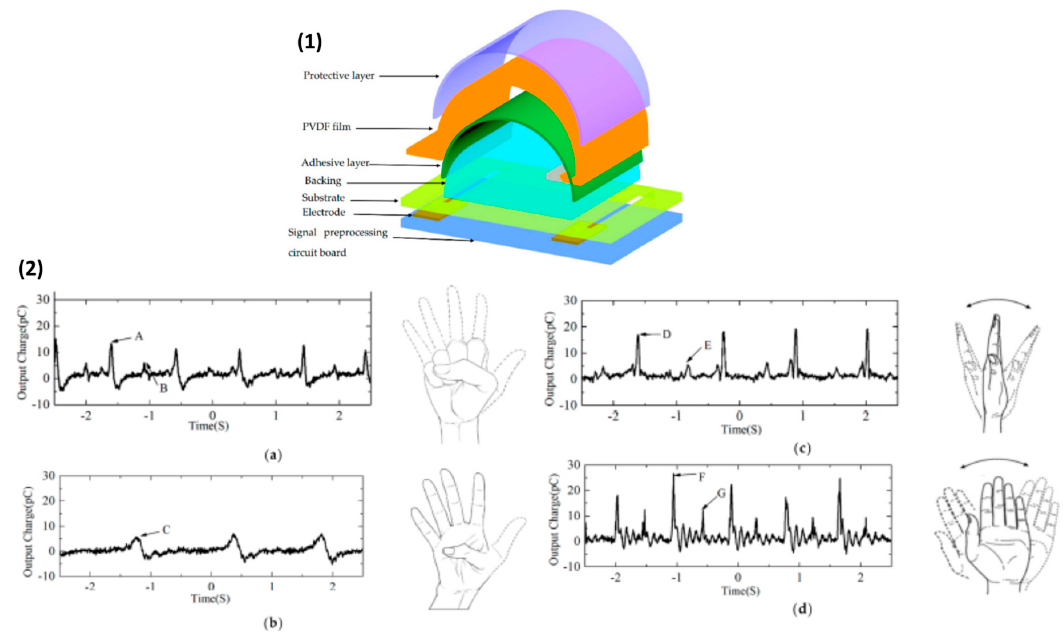
Figure 18. ( 1 ) Structure diagram of wrist PVDF sensor; ( 2 ) Measured response waveforms of the sensor during different hand movements including ( a ) making a fist; ( b ) thumb bending; ( c ) wrist stretching and bending; and ( d ) wrist waving. Reprinted with permission from [37].